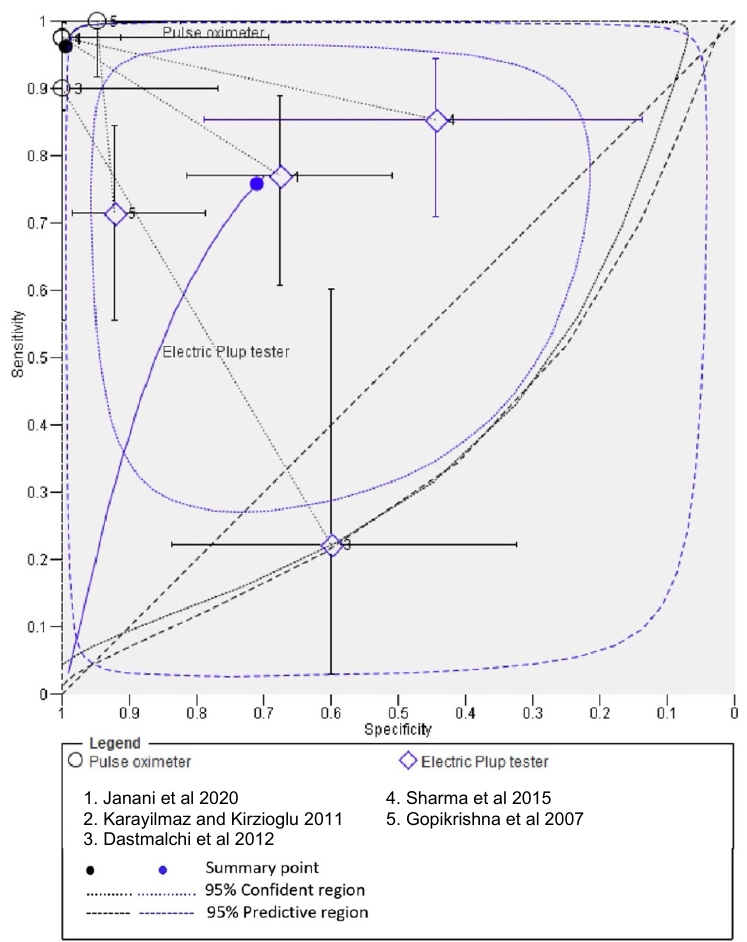
Figure 4. Bivariate meta-analysis of pooled mean sensitivity with PO and EPT [6,10–12,27].